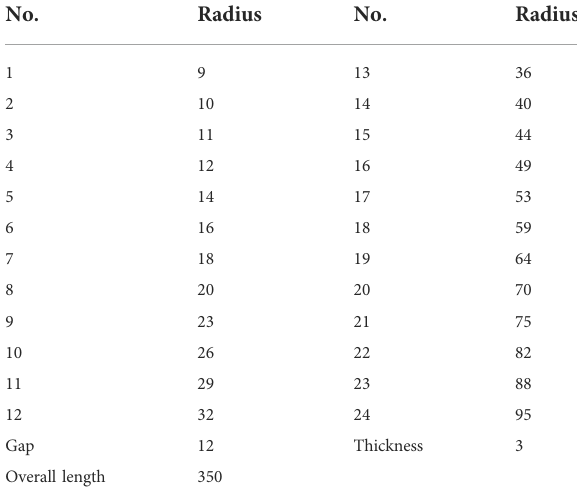
TABLE 1 Geometric parameters (unit: